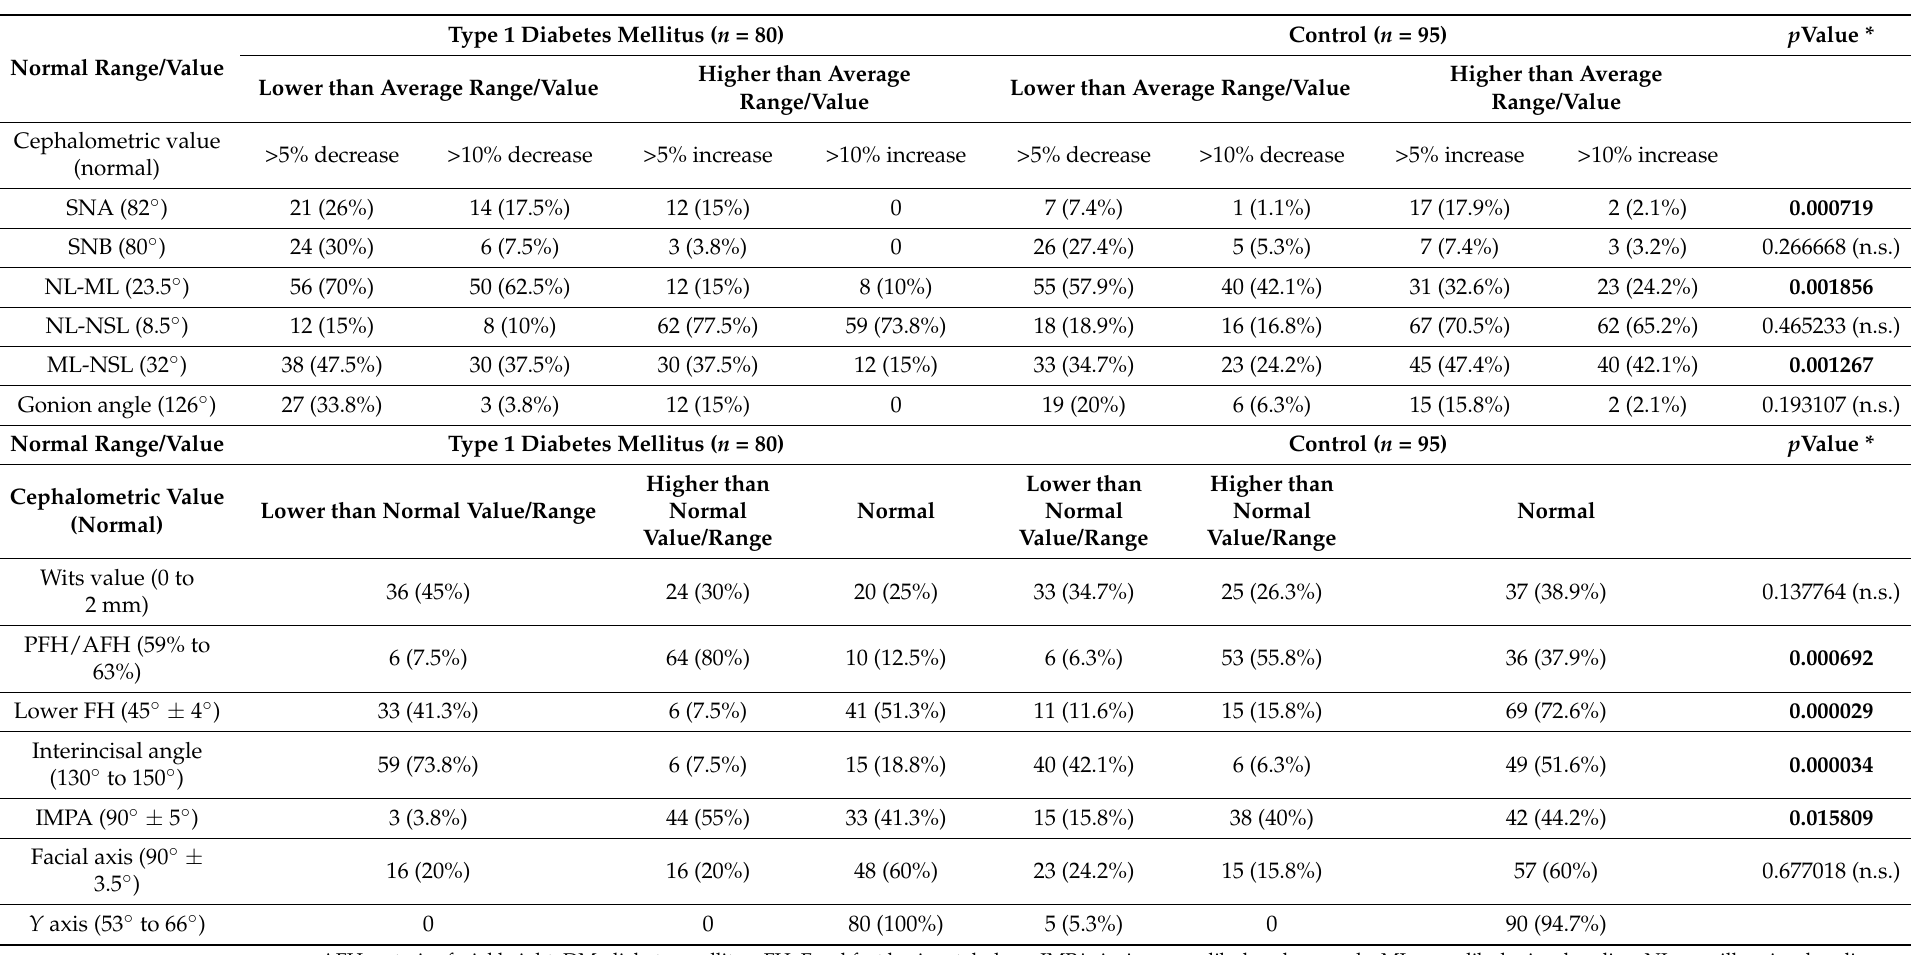
Table 4. Lateral cephalometric values and evaluation data from the Department of Paediatric Dentistry and Orthodontics diabetes ambulance and control